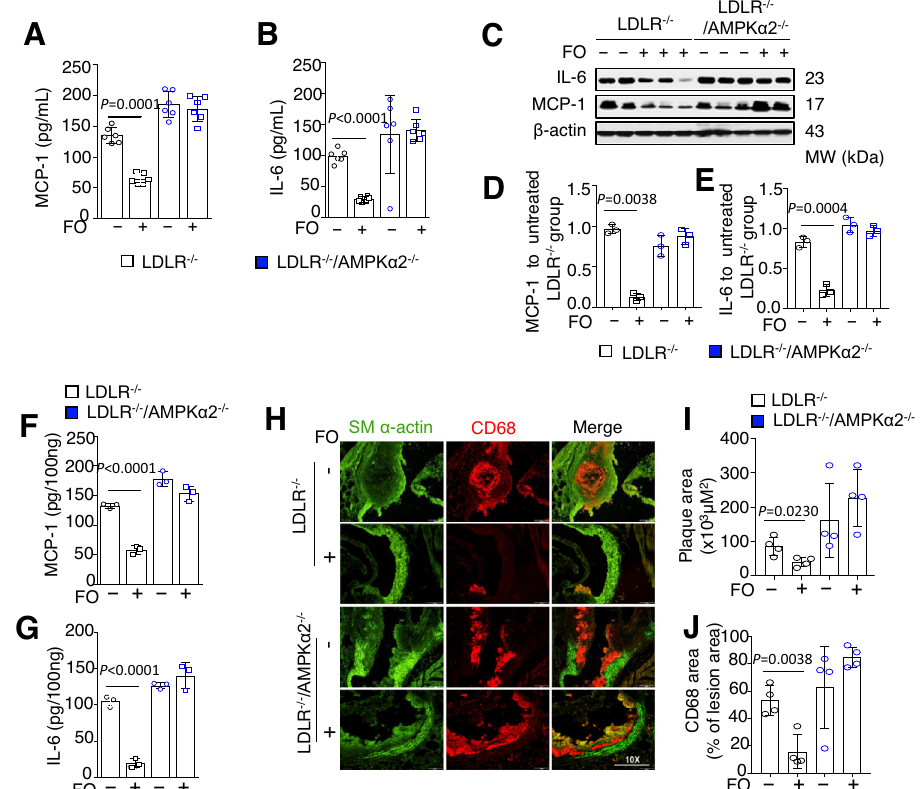
Fig. 2 | AMPK α 2 was required for the anti-in fl ammatory effects of FO in vivo. Serum MCP-1 ( A ) and IL-6 ( B ) levels were measured in LDLR − / − and LDLR − / − / AMPK α 2 − / − mice fed a western diet with or without 5% FO treatment ( n =6). Representative western blot ( C ) and quanti fi cation of MCP-1 ( D ) and IL-6 ( E ) and protein levels in aortic tissues from LDLR − / − and LDLR − / − /AMPK α 2 − / − mice fed a western diet for 12 weeks, with or without 5% FO administration ( n =3), distinctly fromloadingcontrols.ELISAsforMCP-1( F )andIL-6( G )inaortictissuelysatesfrom LDLR − / − and LDLR − / − /AMPK α 2 − / − mice with or without 5% FO administration ( n =3).